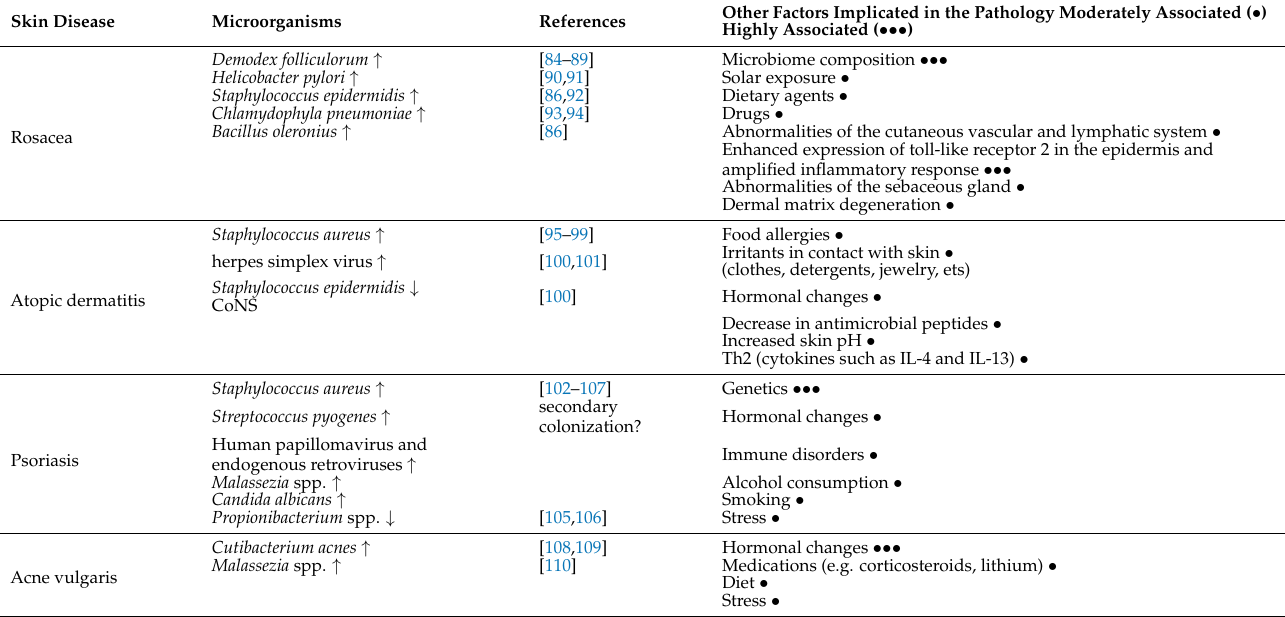
Table 1. Microorganisms and other factors associated with skin